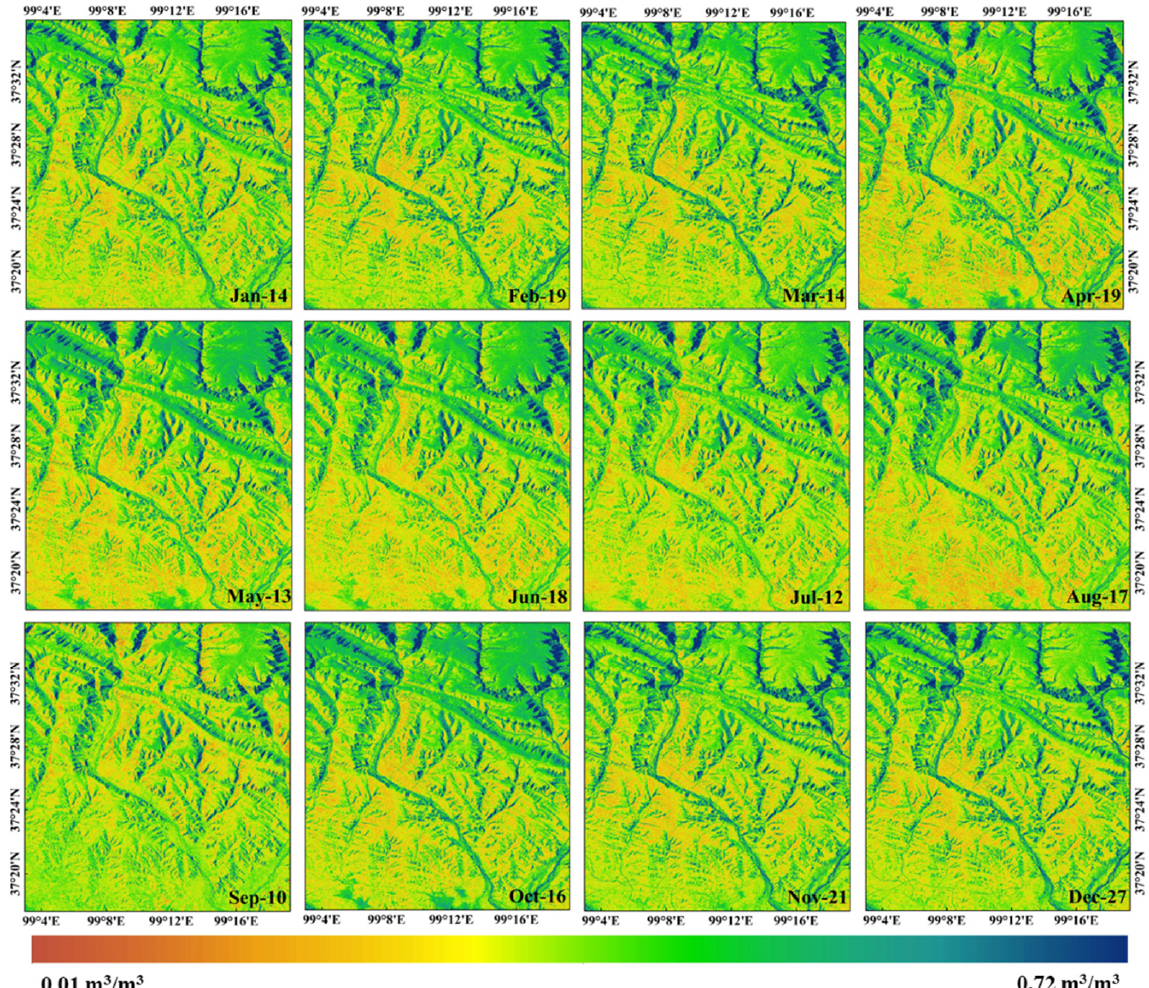
Figure 12. Soil moisture with RF for ascending orbit of Tianjun network for 2020.